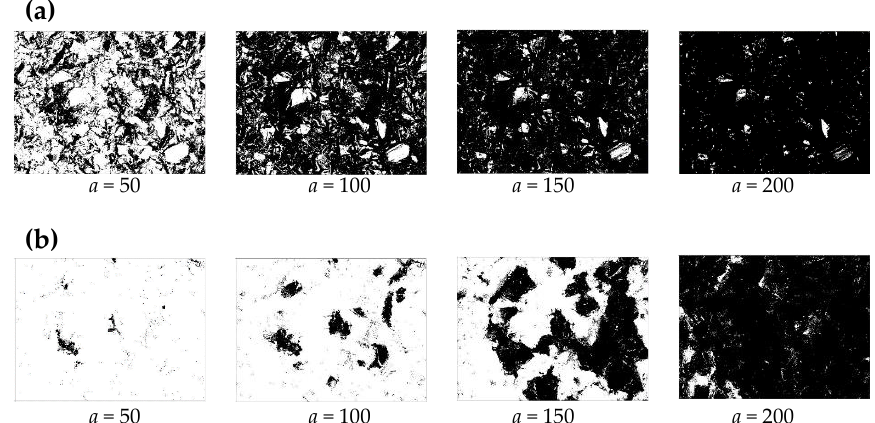
Figure 4. Significance of the threshold. ( a ) Photography-based binary image, ( b ) height-based binary image.